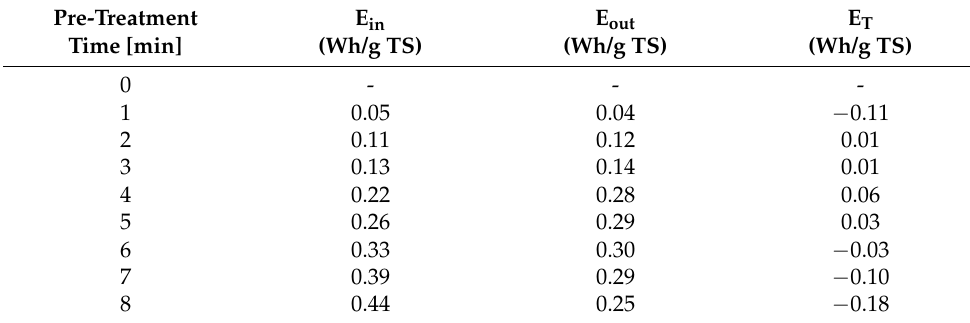
Table 3. Energy efficiency of the PEF treatment of rapeseed straw.